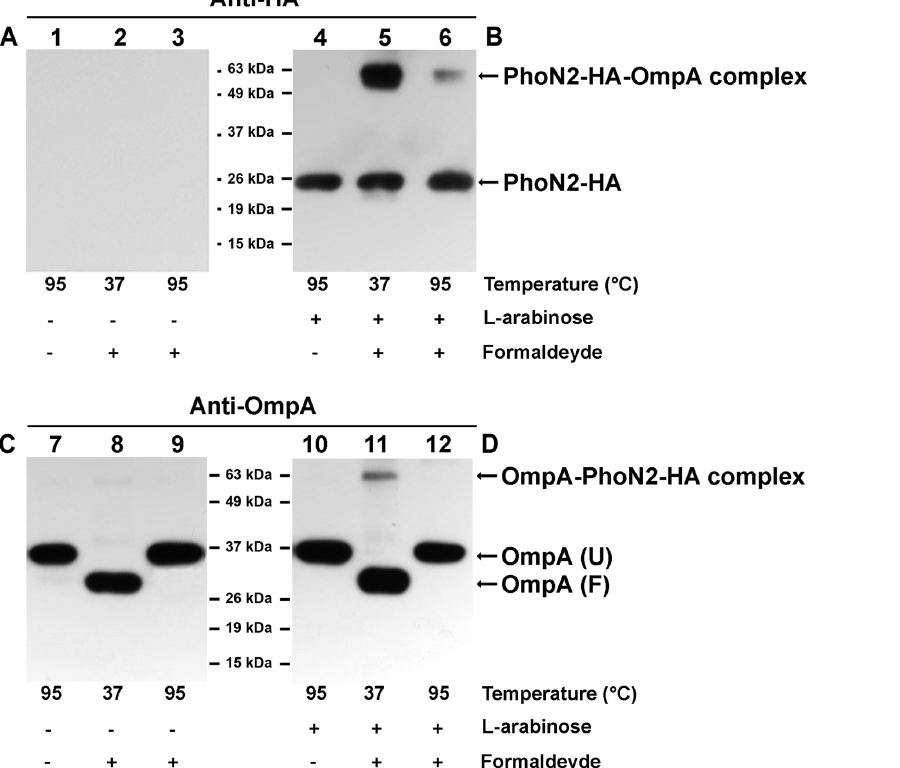
Figure 6. Invivo cross-linking experiments. The 43 PPPP 46 motif of PhoN2 is not required for the PhoN2-OmpA interaction. Cross-linking of HND115 (pHND10) was achieved by treating bacteria with formaldehyde to a final concentration of 1%, as described in Materials and Methods. Samples were suspended in Laemmli buffer and either heated at 37 u C for 10 min to maintain cross-links or at 95 u C for 20 min to break cross-links. Equal amounts of proteins were analyzed by Western blot. A protein molecular weight marker (Pierce) was used to determine the molecular weight of proteins. Immunoblotting was carried out with monoclonal anti-HA (Panels A and B) or polyclonal anti-OmpA antibodies (Panels C and D). Expression of PhoN2-HA was achieved by growing bacteria in the presence of 0.016% of L-arabinose. Panels A and C, bacteria not induced with L- arabinose; Panels B and D, L-arabinose induced bacteria. OmpA (U), unfolded OmpA; OmpA (F), folded OmpA [48]. Experiments were repeated at least three times and typical results are shown.